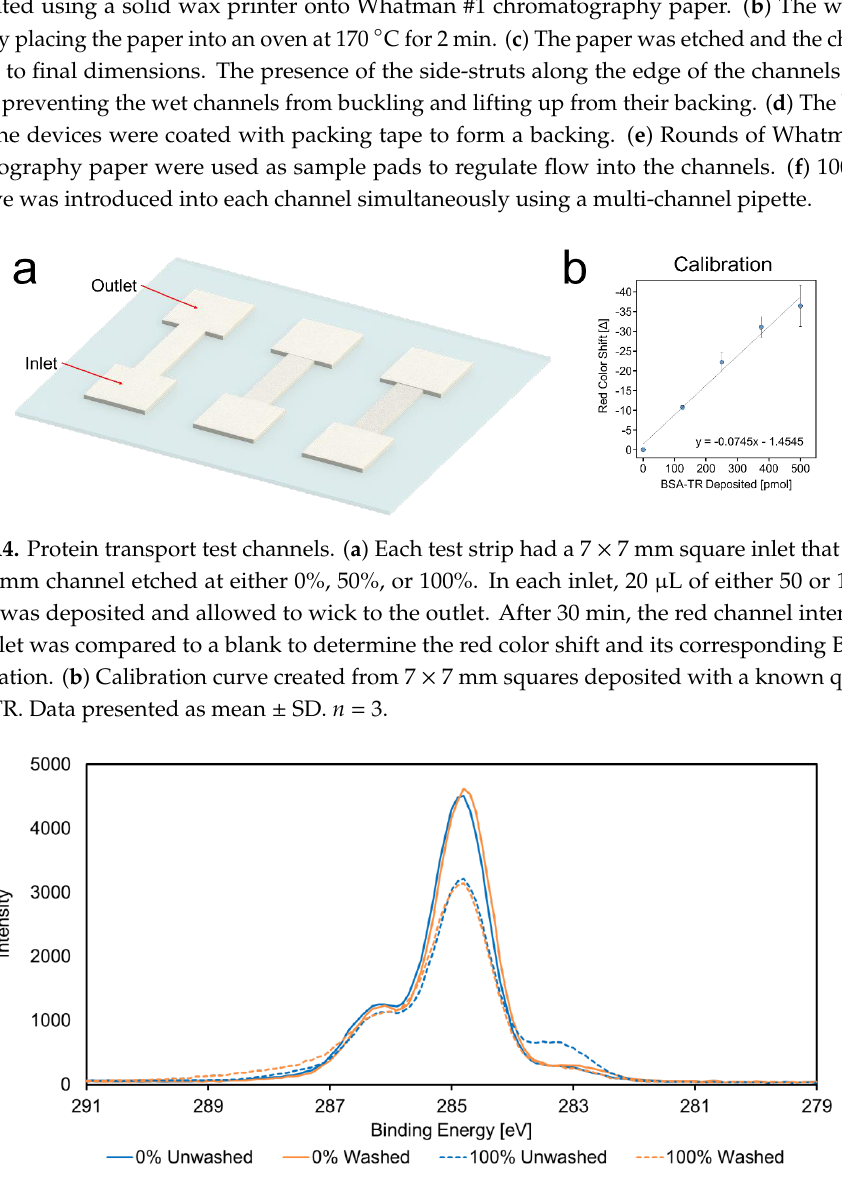
Figure A6. Depiction of why the angled wicking 0 degrees is faster than the previous data set. ( a ) Meniscuses form evenly on both sides of the paper. ( b ) External capillaries formed by the backing likely cause faster fluid delivery to the inlet of the channels.